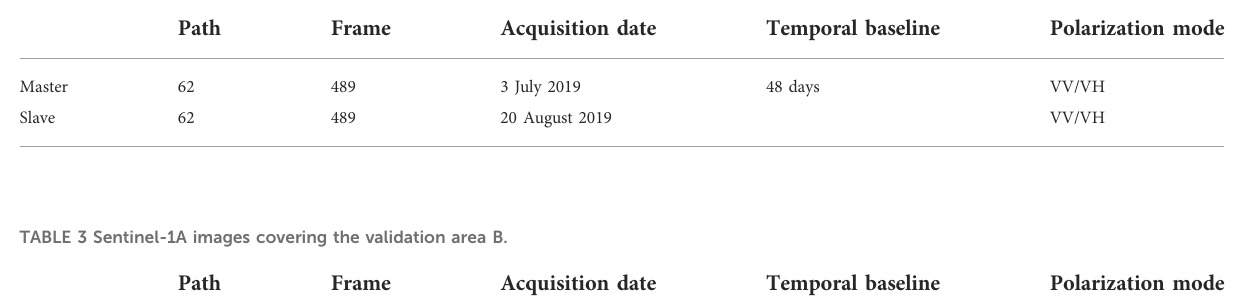
TABLE 2 Sentinel-1A images covering the study area and validation area A.